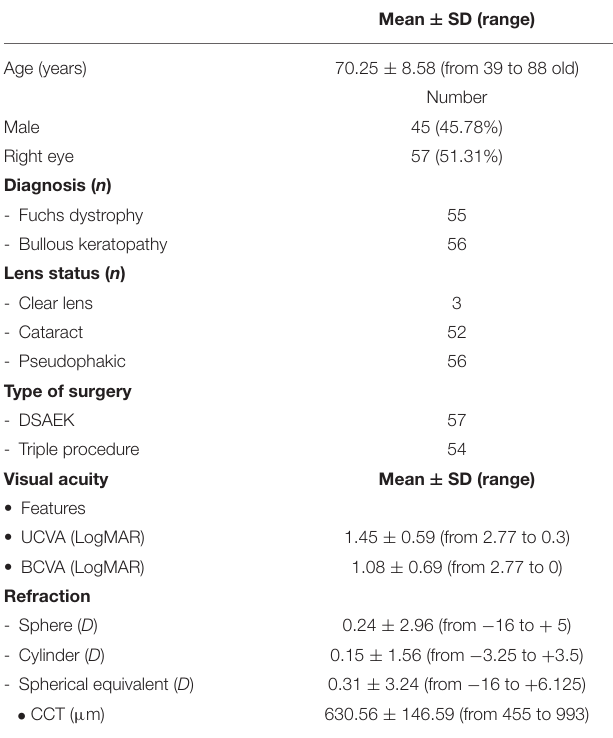
TABLE 1 | Baseline demographic, and ocular characteristics of the sample